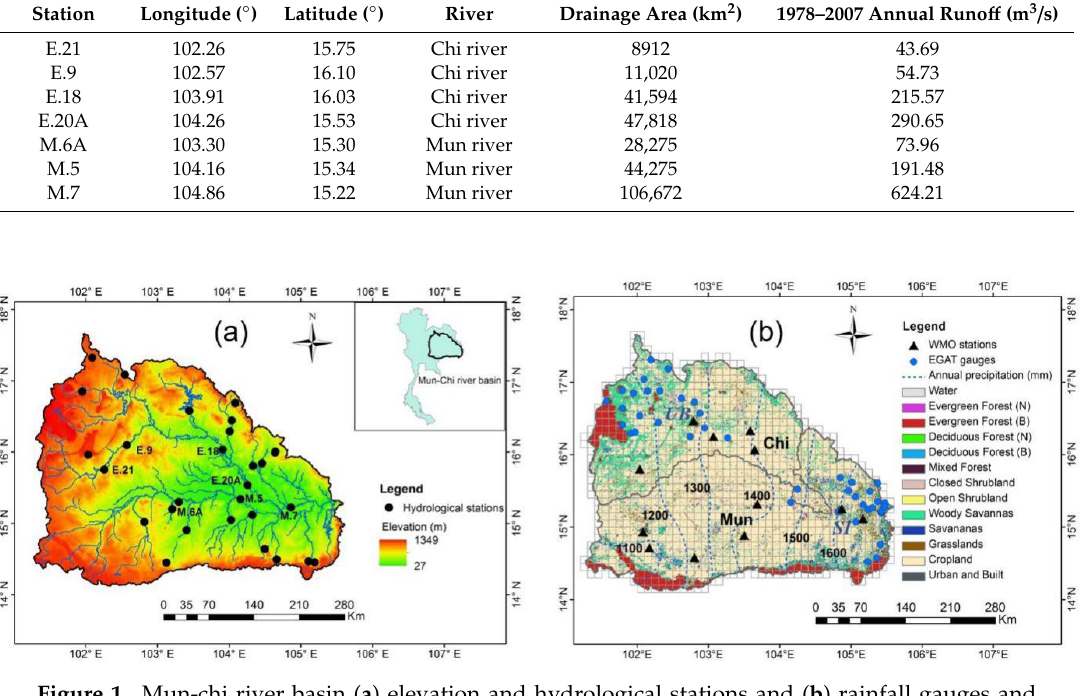
Table 1. The hydrological stations in the mainstream of Mun-chi river Basin.